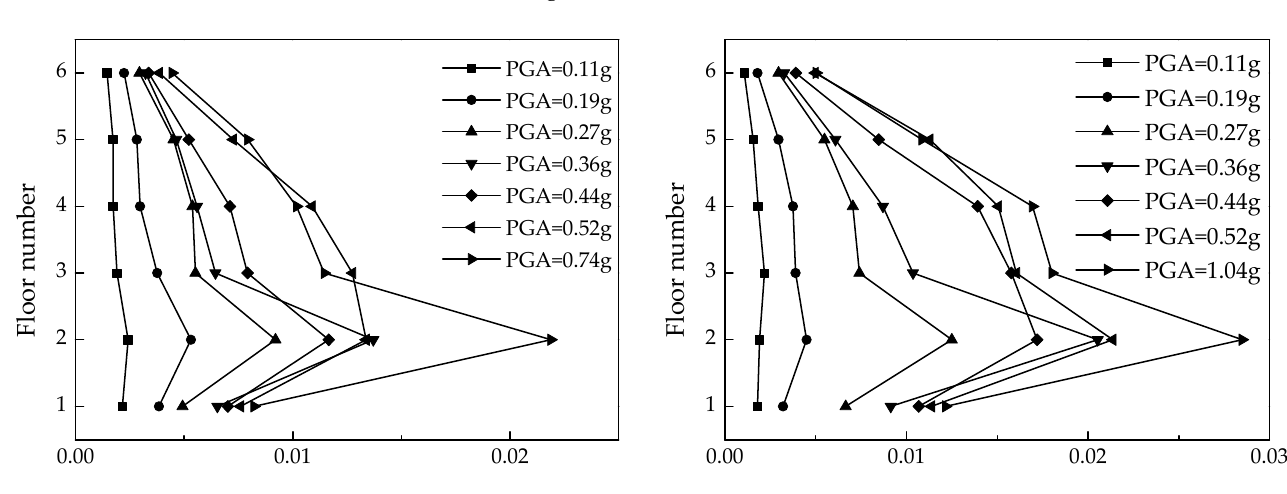
Figure 16. Envelope diagram of the interlayer displacement angle of two frames with short columns under different earthquake effects. ( a ) Frame FS1 with RC short columns; ( b ) Frame FS2 with ECC short columns.